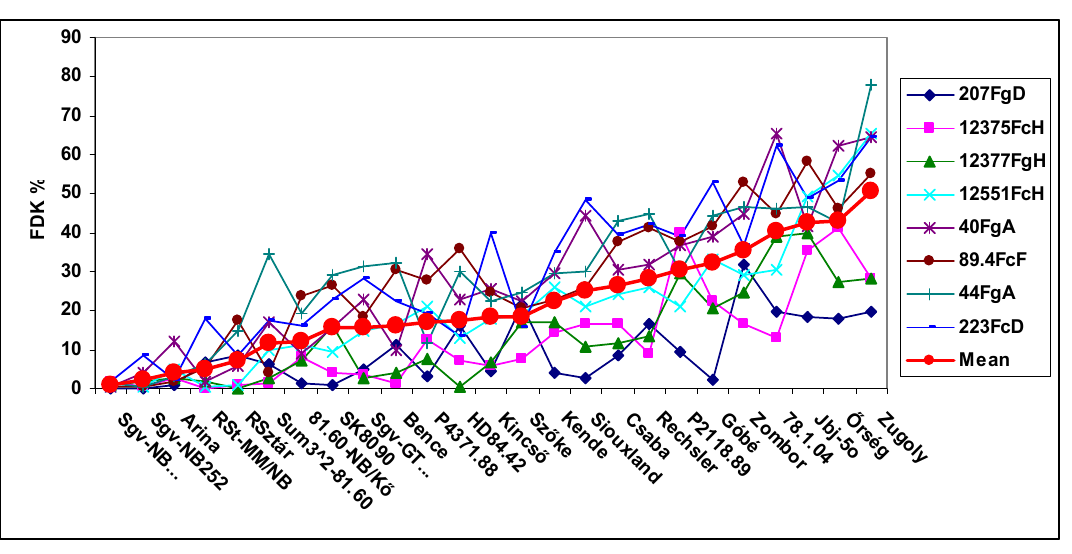
Figure 2. Resistance of winter wheat lines F. graminearum and F. culmorum isolates 1994–1996. Fusarium damaged kernels (FDK), percentage, [34]. Larger variations in surveying of the susceptible cultivars could suggest that the disease development is more variable in susceptible cultivars due to a mixture of factors including the genotypes. The most resistant ones have high stability and low